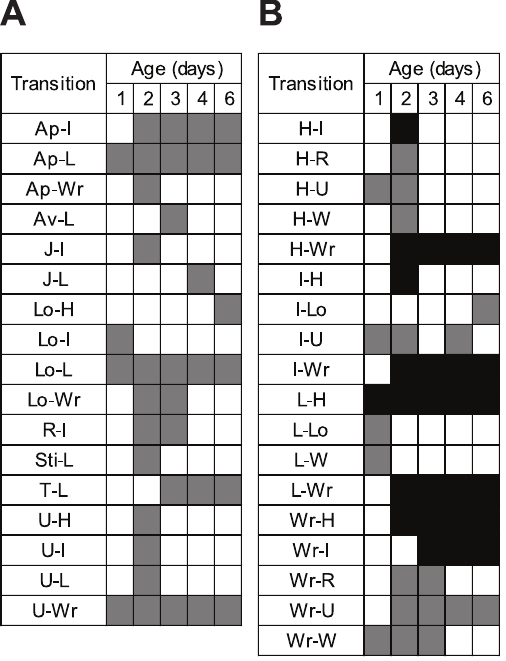
Table 3. Statistically significant behavioral transitions not obviously associated with ontogeny of aggression.